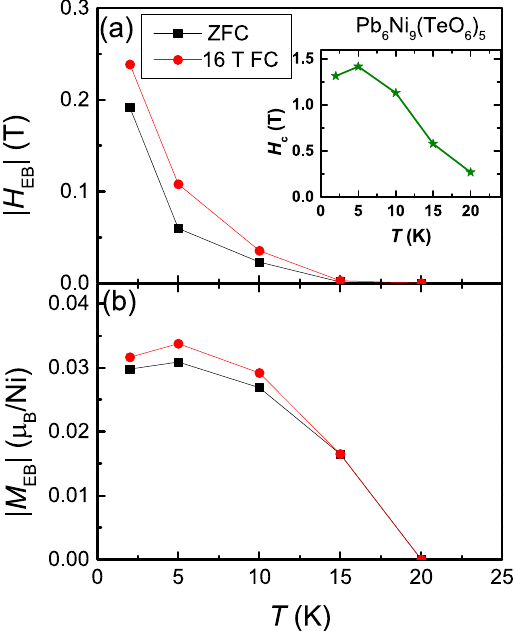
Figure 5. ( a ) and ( b ). The values of | H EB | and | M EB | vs. T . Inset of ( a ) plots H c vs. T .